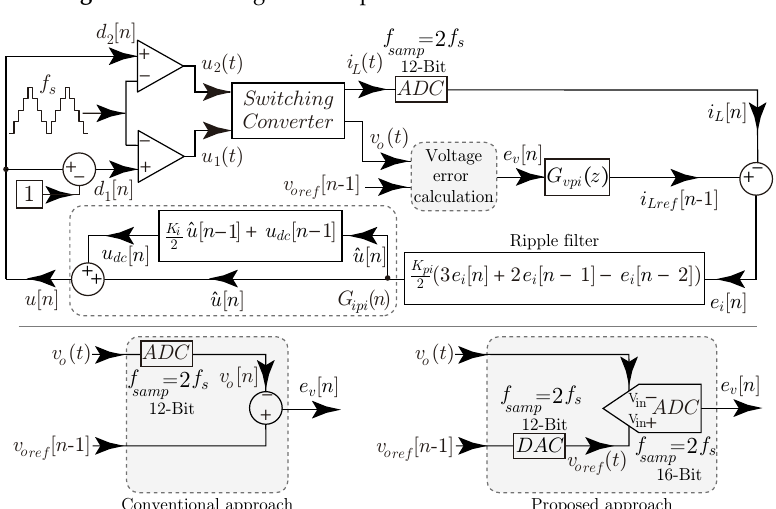
Figure 3. Block diagram of the digital controller for the voltage regulation of the buck-boost converter. Bottom Left: Conventional voltage error subcircuit. Bottom Right: Proposed improved approach